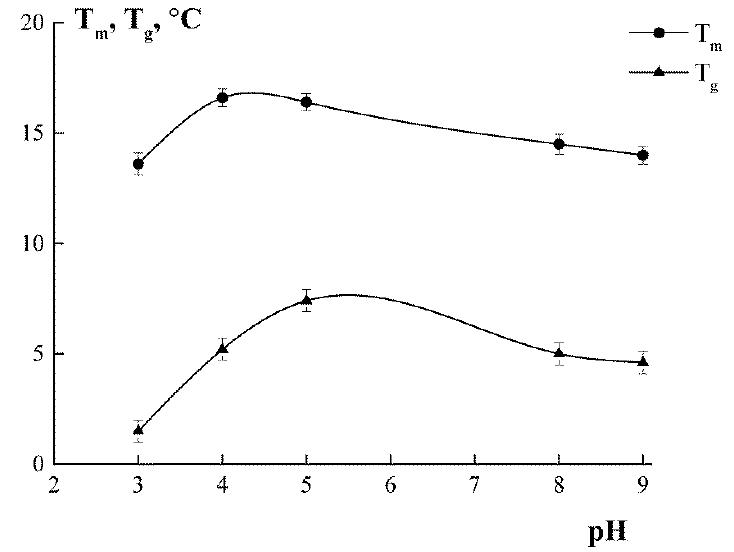
Figure 6. Gelling, T g , and melting, T m , temperatures of cod gelatin gels depending on extraction pH. C G = 10 wt.%.